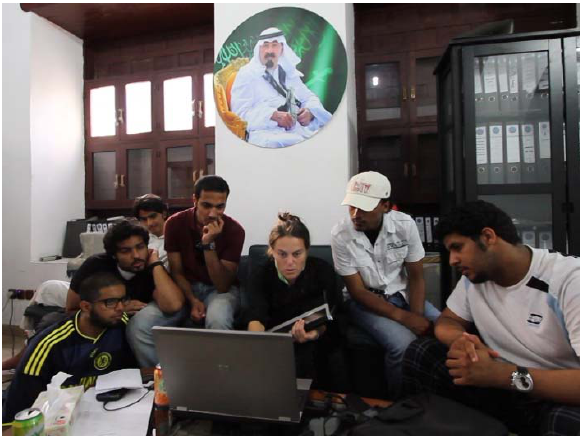
Figure 13. cooperation between students of KAU and TUW teaching